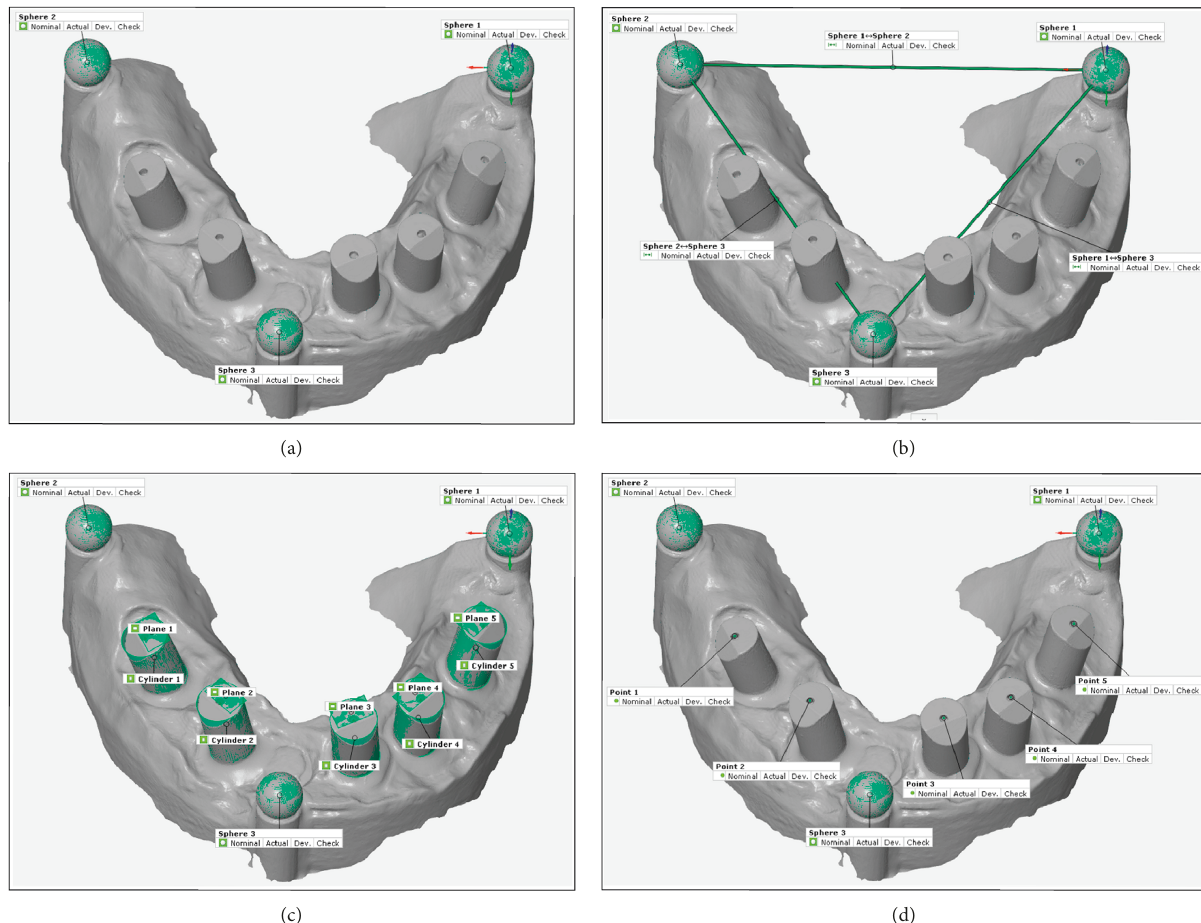
Figure 4: Four different measurement procedures. (a) Construction of the spheres and alignment of 3D model in the same CMM coordinate position. (b) Linear distances in between the center of the spheres. (c) Construction of planes and cylinders for all implants. (d) Installation of the center points of all